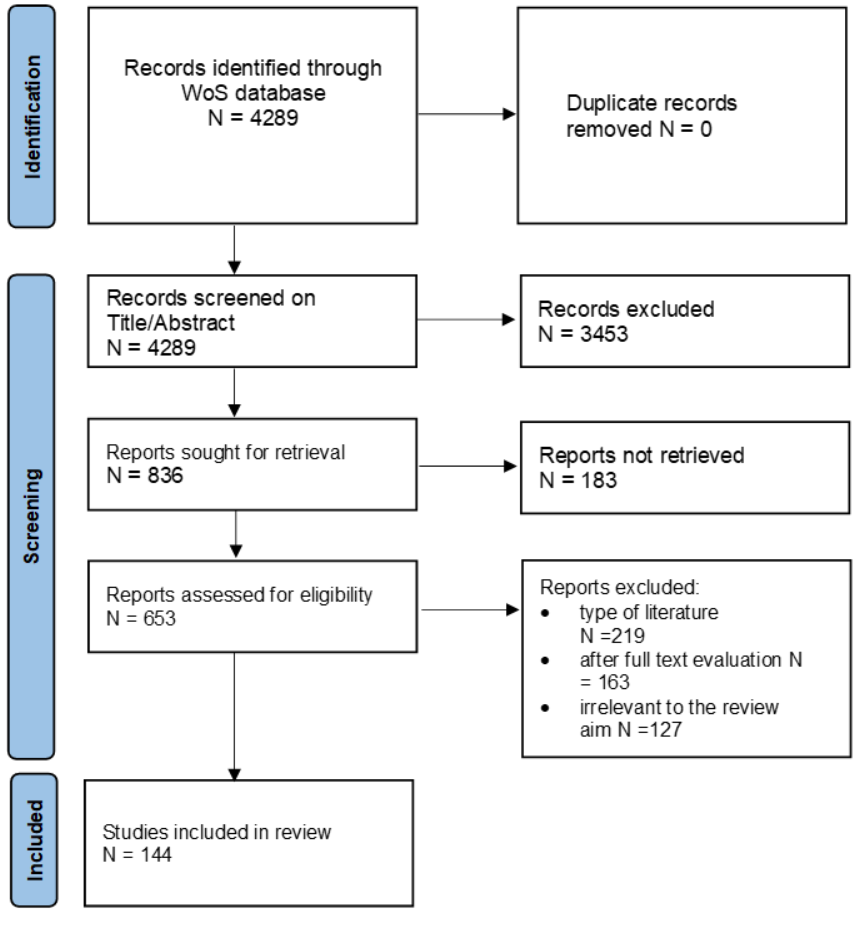
Figure 1. PRISMA flow chart